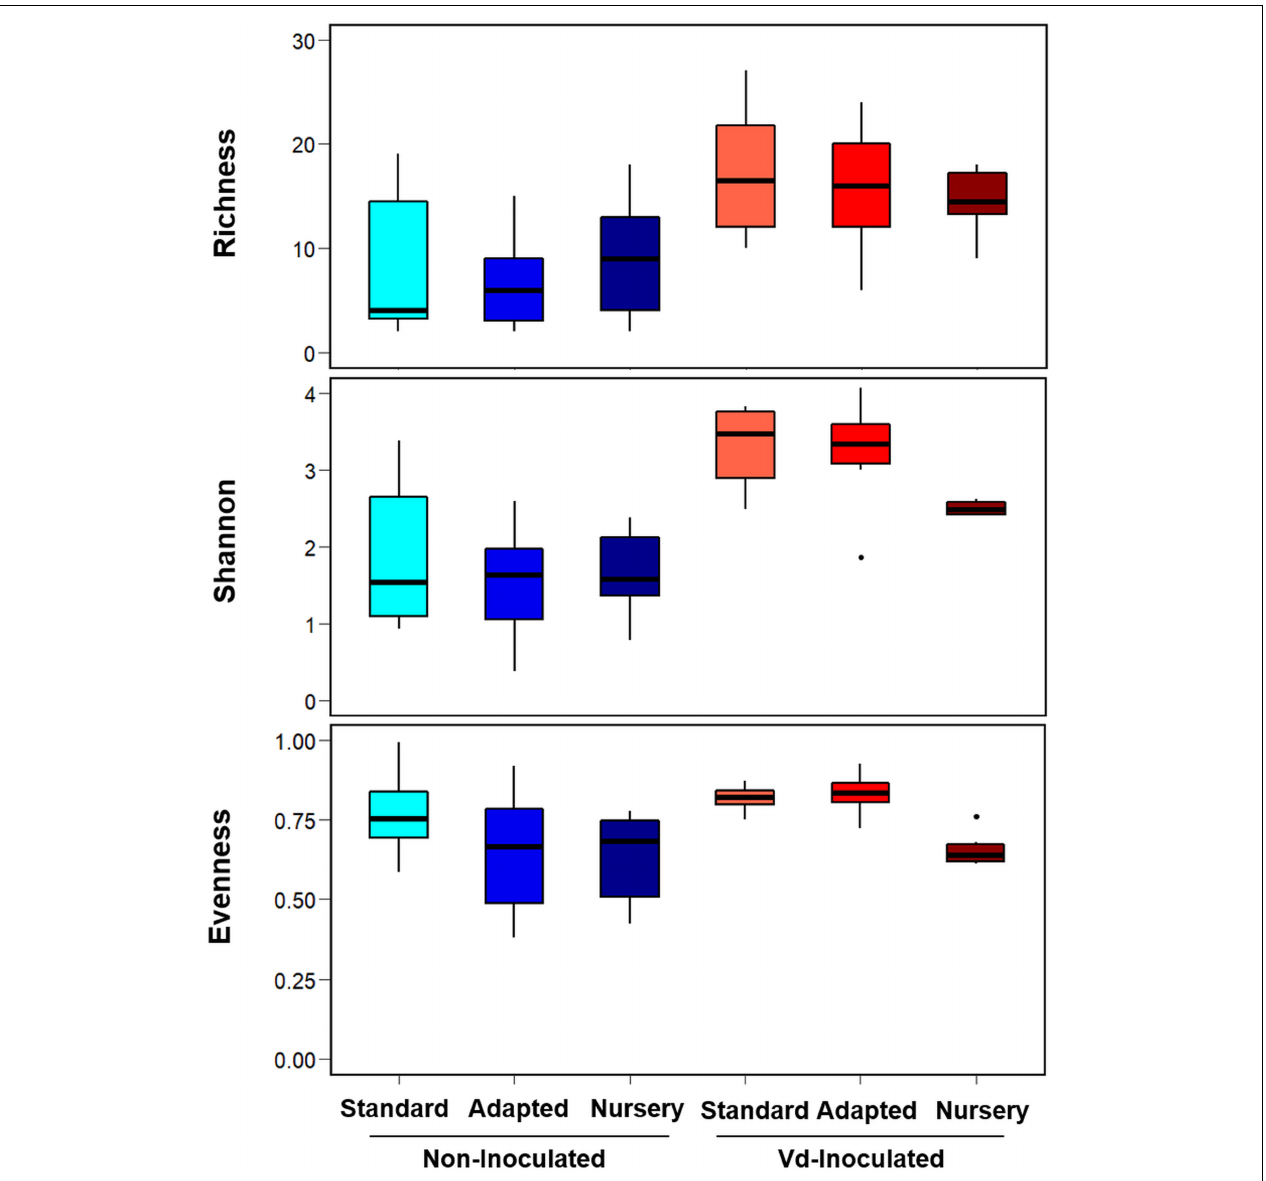
FIGURE 2 | Boxplots of Richness, Shannon, and Evenness alpha diversity indices at OTU taxonomic level in olive xylem from Verticillium dahliae ( Vd )-inoculated and non-inoculated “Ac-18” plants following in vitro (standard and adapted) and nursery propagation methods. Boxes represent the interquartile range, while the horizontal line inside the box defines the median and whiskers represent the lowest and highest values of six values for each treatment combination. For all three indexes and propagation methods, values on Vd -inoculated plants were significantly higher compared to that on non-inoculated treatments according to the Scheirer–Ray–Hare test at P <